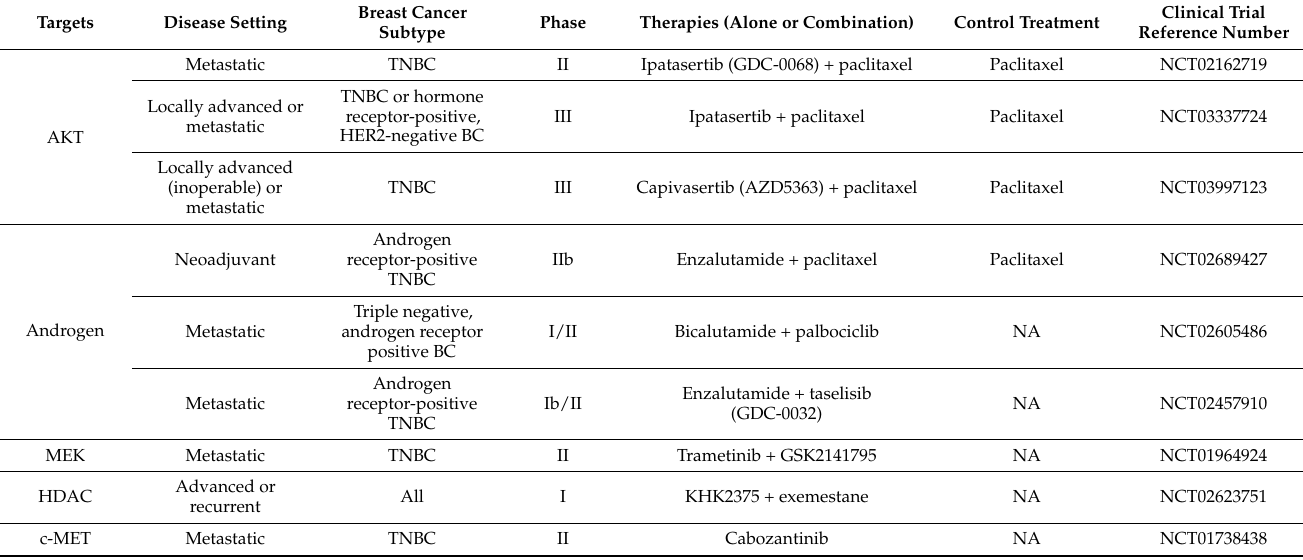
Table 3. Ongoing clinical trials of upcoming targeted therapies for patients with